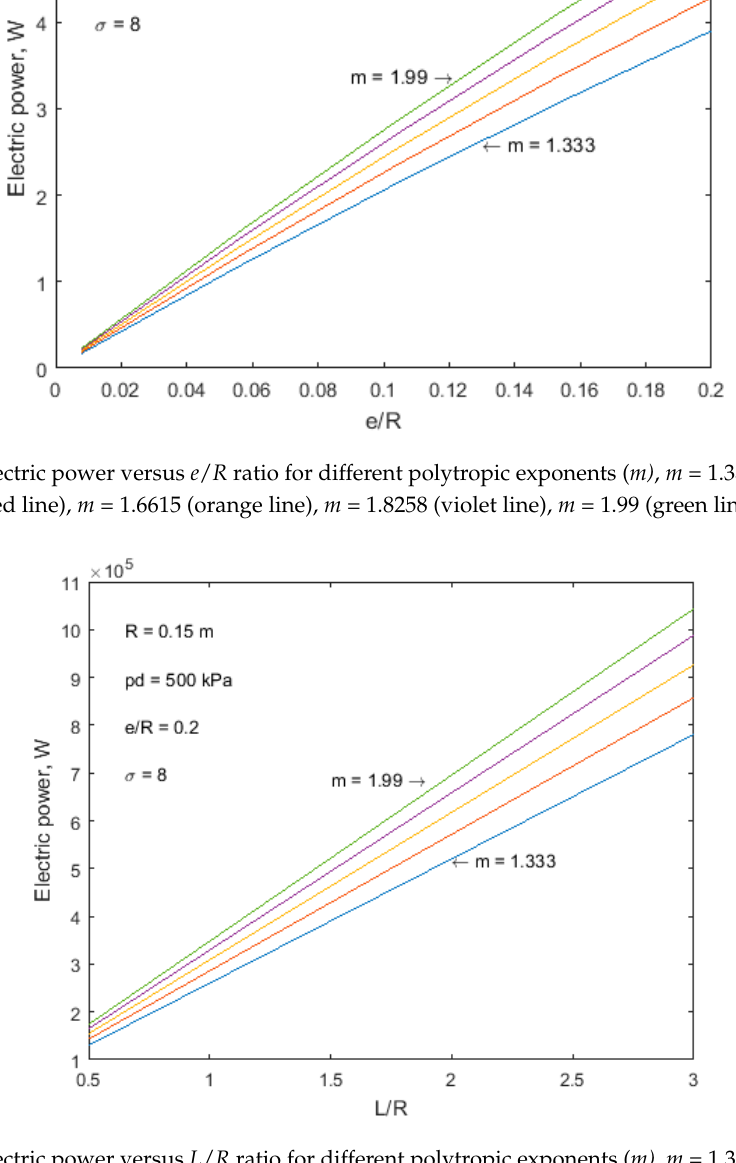
Figure 12. Electric power versus L / R ratio for different polytropic exponents ( m) , m = 1.333 (blue line), m = 1.4973 (red line), m = 1.6615 (orange line), m = 1.8258 (violet line), m = 1.99 (green line).